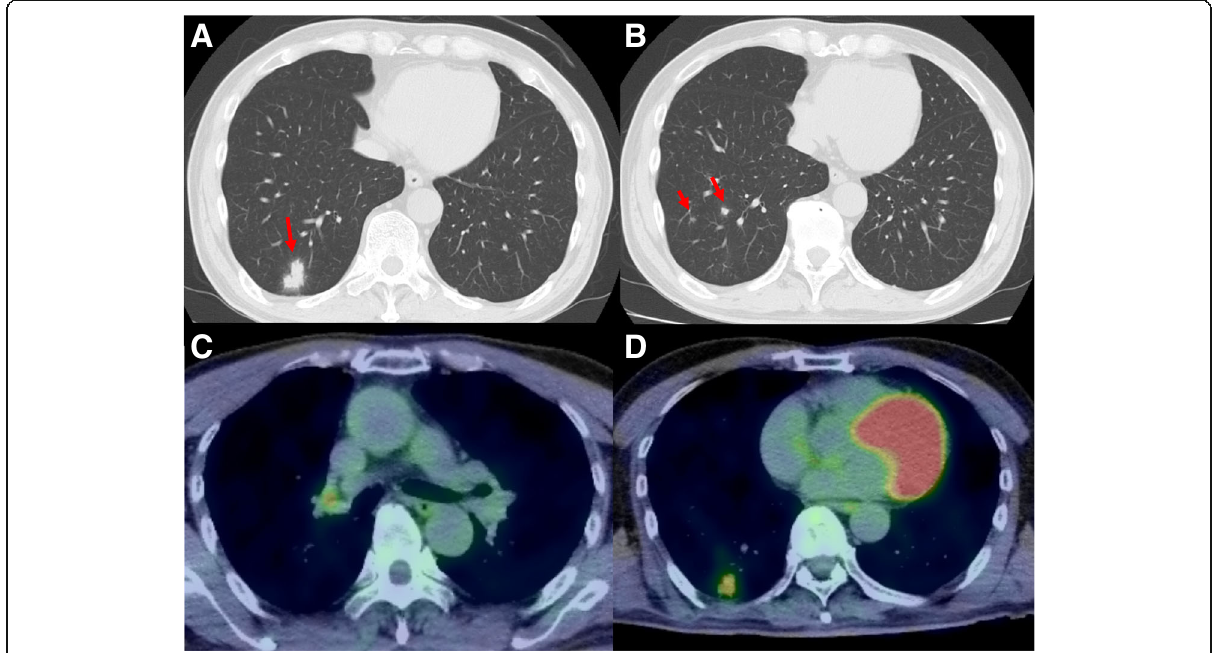
Fig. 1 Imaging findings. a Computed tomography showing the pulmonary nodule (24 mm) in the posterior basal segment of the right lung. b Computed tomography showing two small nodules (8 mm and 6 mm) in the posterior basal segment of the right lung. c Fluorodeoxyglucose positron emission tomography showing abnormal uptake in the main nodule. d Fluorodeoxyglucose positron emission tomography showing abnormal uptake in right hilar lymph